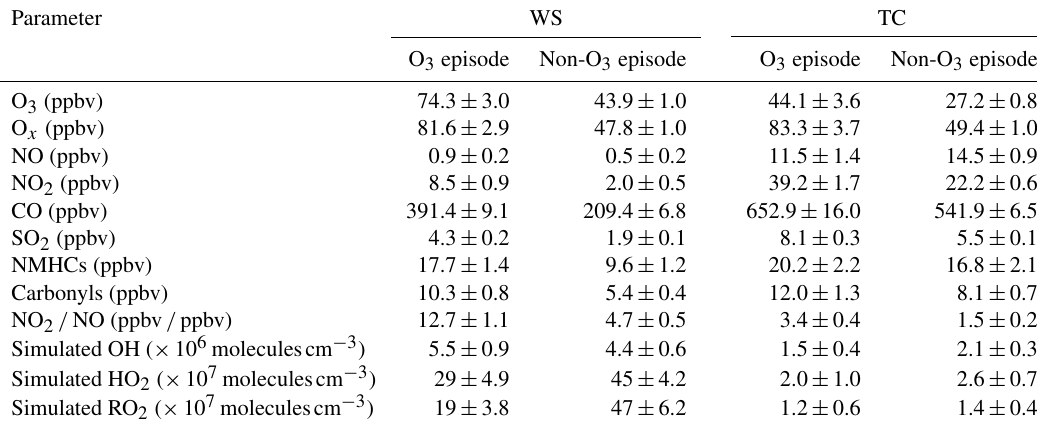
Table 3. Descriptive statistics (mean ± 95% C.I.) of measured air pollutants and simulated OH, HO 2 and RO 2 at the two sites during O 3 episodes and non-O 3 episodes